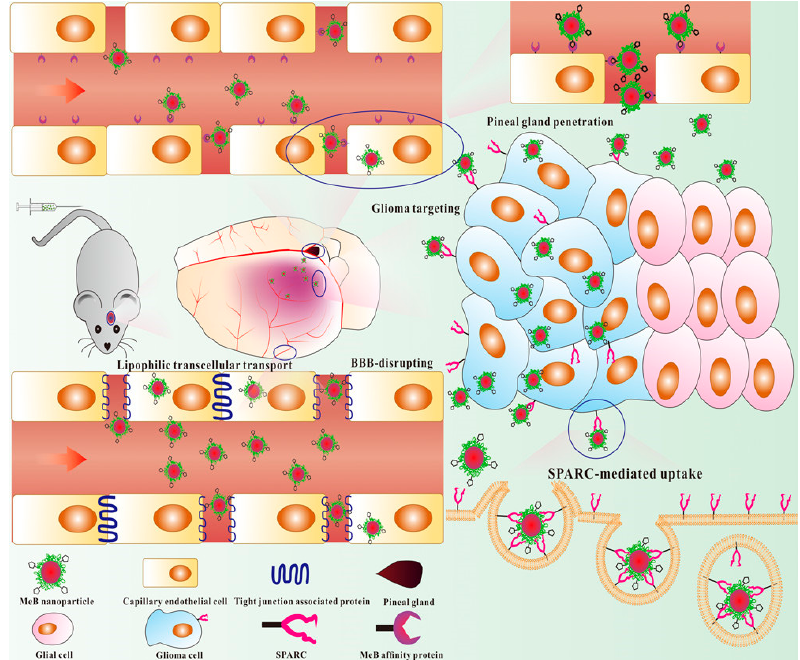
Figure 5. Schematic diagram of possible BBB penetration pathways and glioma-targeting ability of BPE–BSA-based NPs. Reproduced with permission from Liang, J.; Gao, C.; Zhu, Y.; Ling, C.; Wang, Q.; Huang, Y.; Qin, J.; Wang, J.; Lu, W.; Wang, J. Natural Brain Penetration Enhancer-Modified